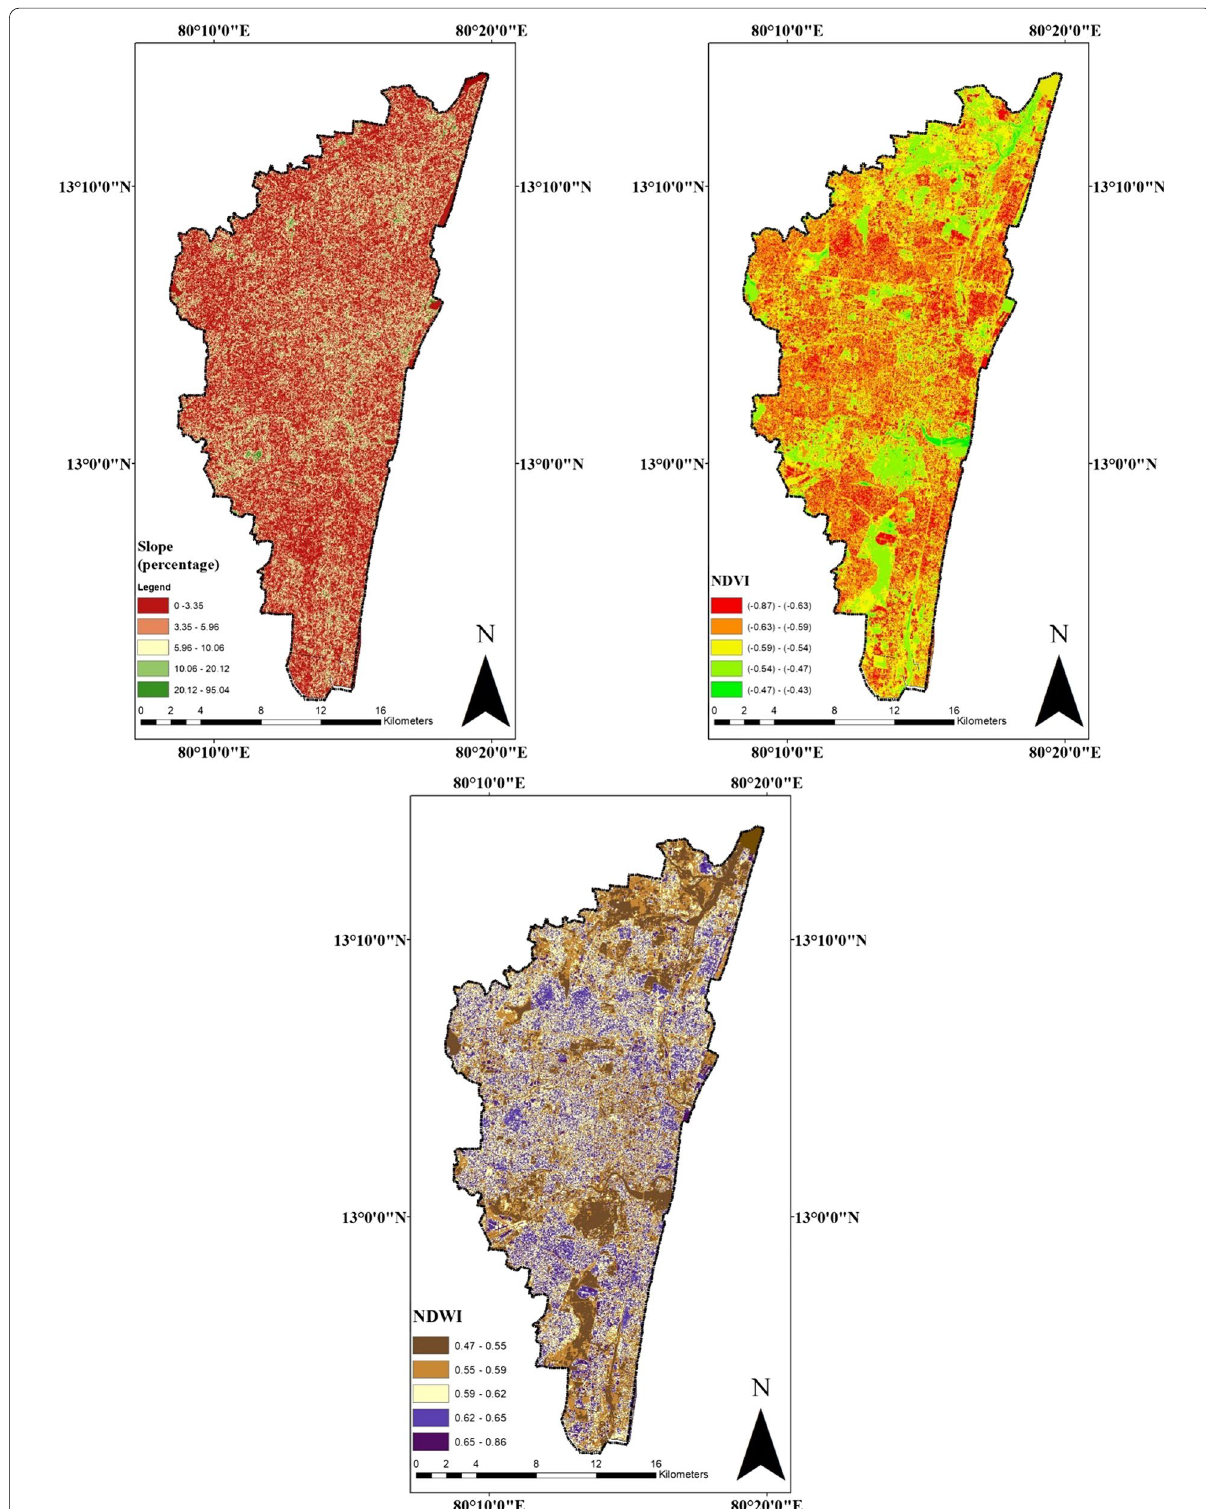
Fig. 6 Slope, NDVI and NDWI